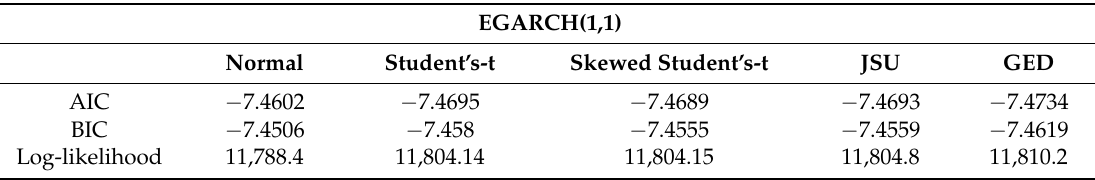
Table 2. Daily variance forecast: EGARCH(1,1) model.